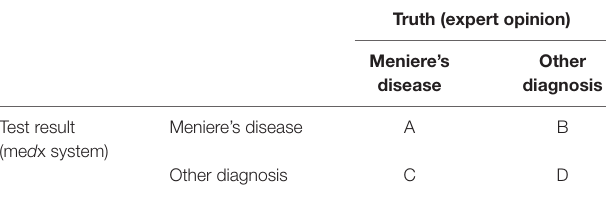
TaBle 1 | Example for the calculation of diagnostic parameters for me d x system.